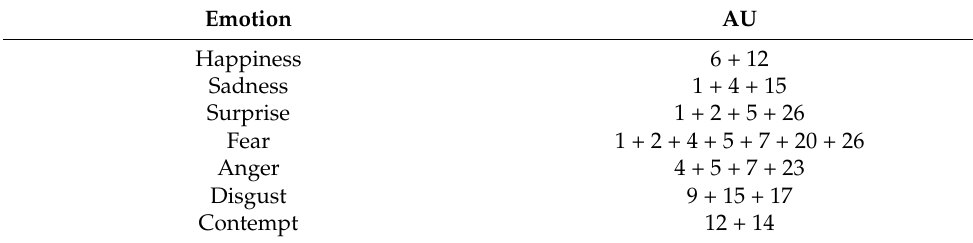
Table 2. List of simple emotions in terms of AUs.